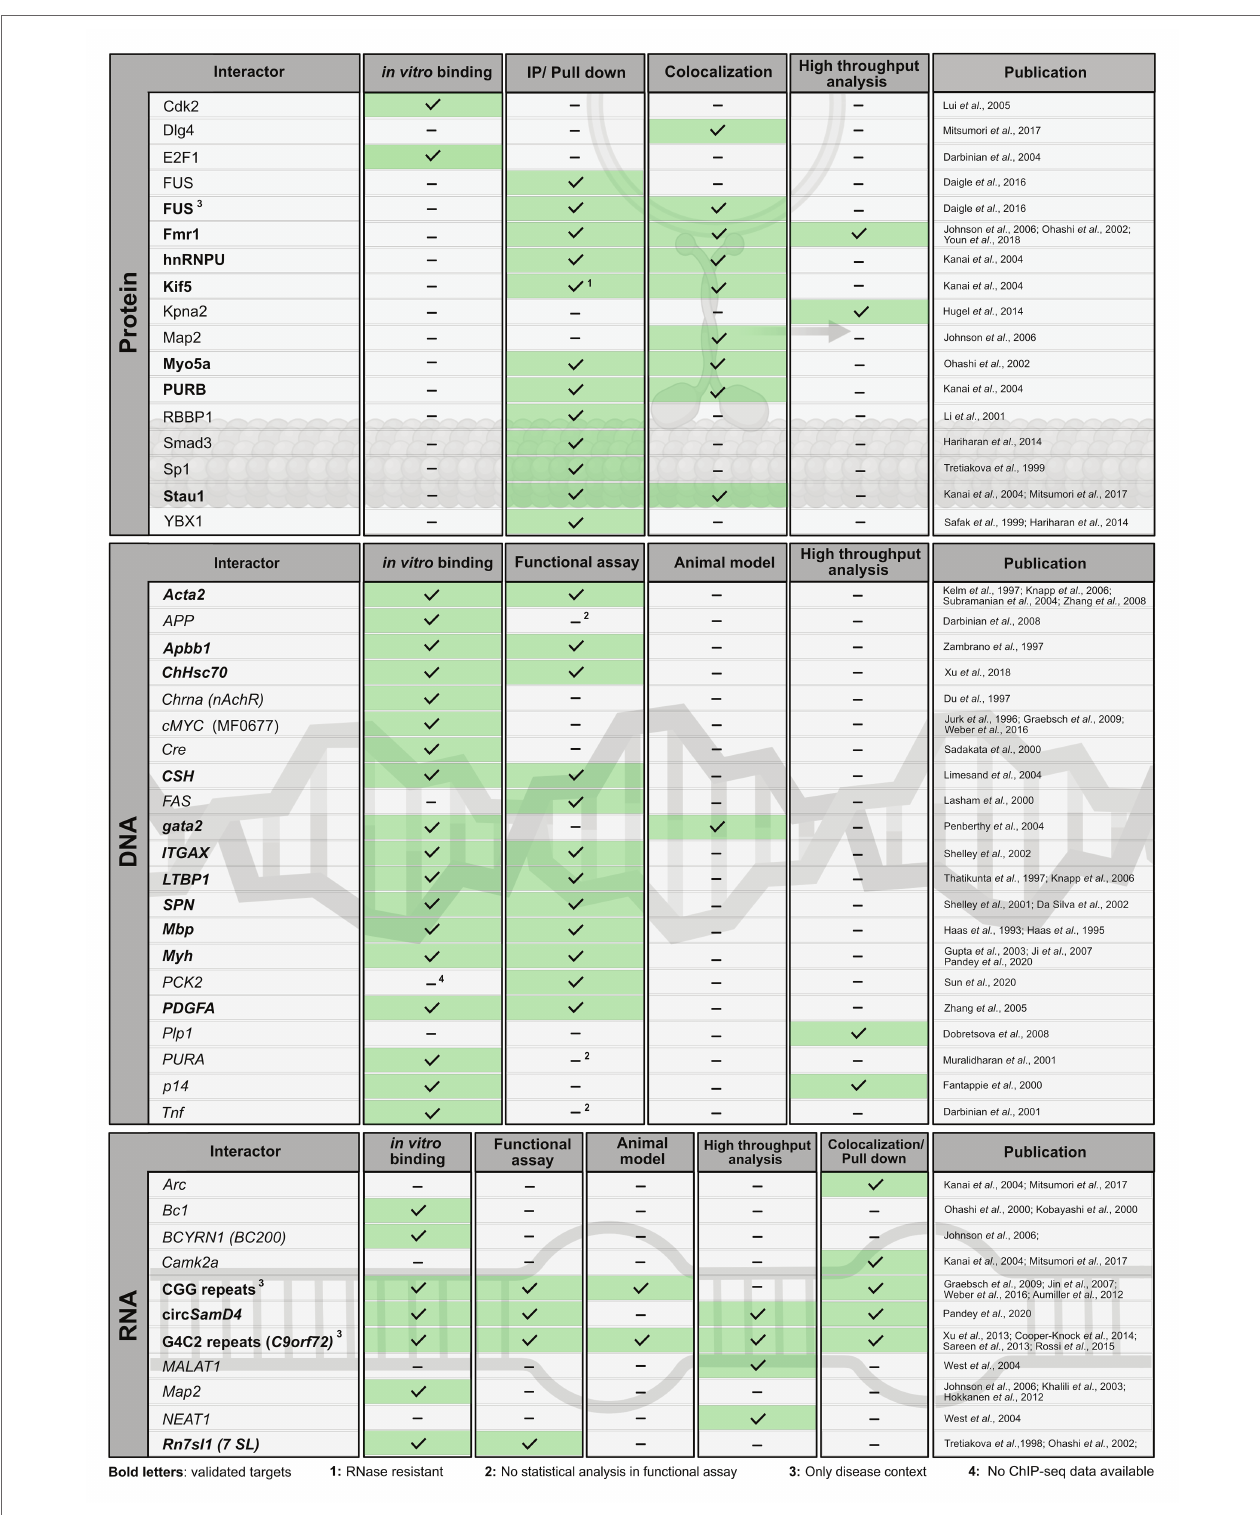
FIGURE 4 | Published interaction partners of the PURA protein. For all “Interactors” (left column) the method used to observe interactions is indicated by a checkmark and green background in the respective column. Well-validated interaction partners of PURA protein are marked in bold letters. For proteins, interaction partners were defined in this study as well validated when experimental evidence is available from each of the following two categories: (i) in vitro binding